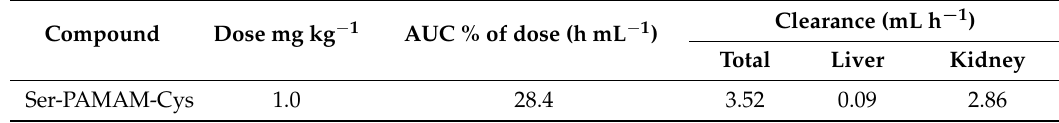
Table 1. Pharmacokinetic parameters of